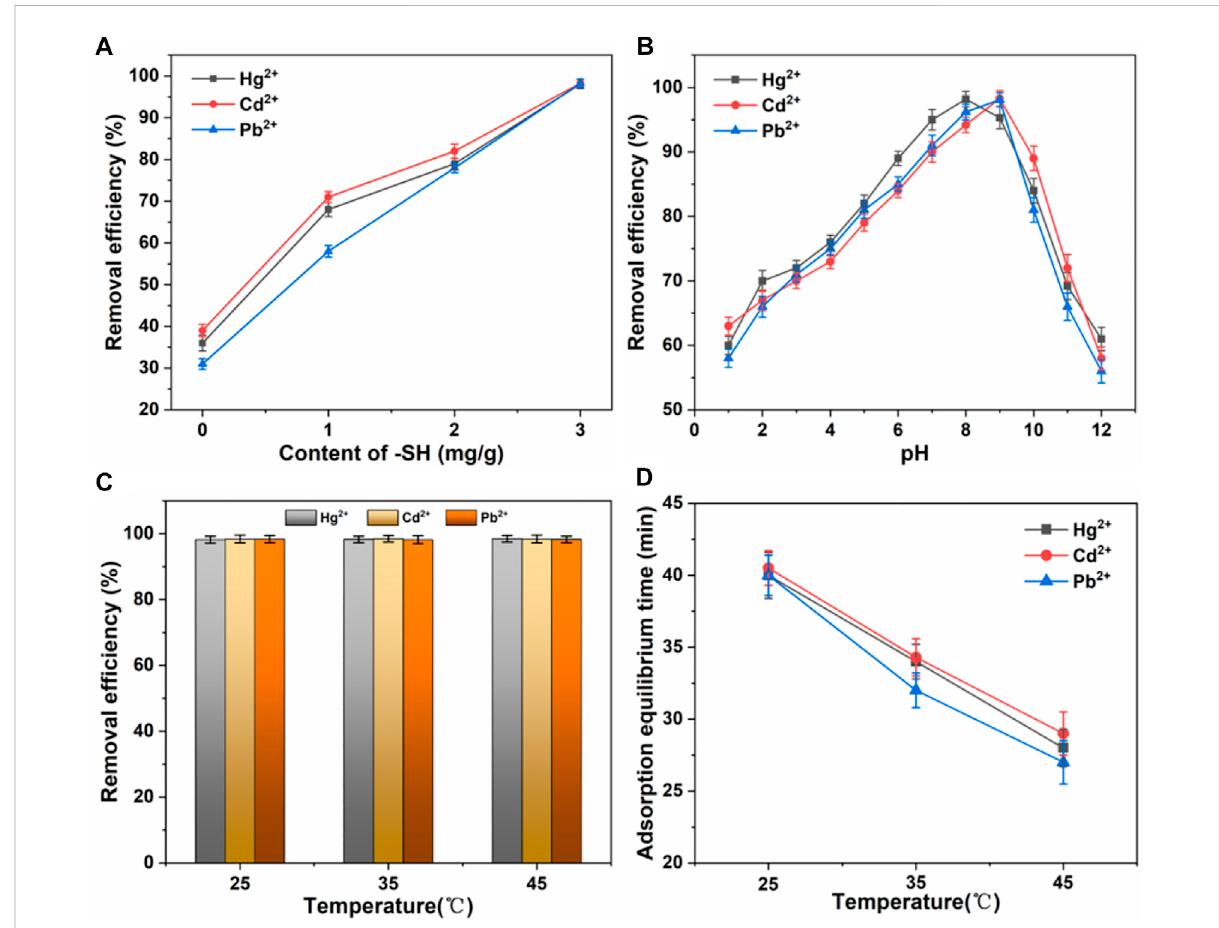
FIGURE 4 (A) Effectof-SHcontentonadsorptionef fi ciency. (B) EffectofpHonadsorptionef fi ciency. (C,D) Effectoftemperatureonadsorptionef fi ciency and equilibrium